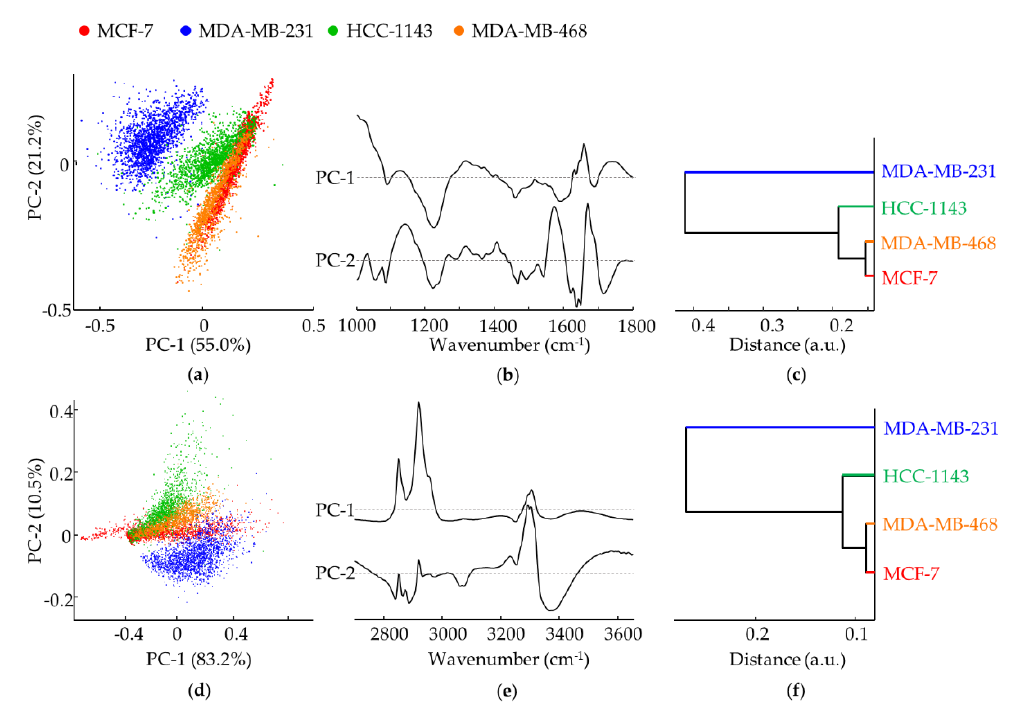
Figure 2. PCA of FTIR data for all cell lines studied (MCF-7, MDA-MB-231, HCC-1143 and MDA- MB-468). ( a , b ) Scores and loading plots of the fingerprint region (1000–1800 cm − 1 ). ( c ) Hierarchical clustering-derived dendrogram of the mean fingerprint FTIR spectra for the four cell lines. ( d , e ) Scores and loading plots of the high wavenumber region (2700–3650 cm − 1 ). ( f ) Hierarchical clustering-derived dendrogram of the mean high-wavenumber FTIR spectra for the four cell lines. For clarity’s sake the spectral loadings are offset, the dashed horizontal lines indicating zero loading.